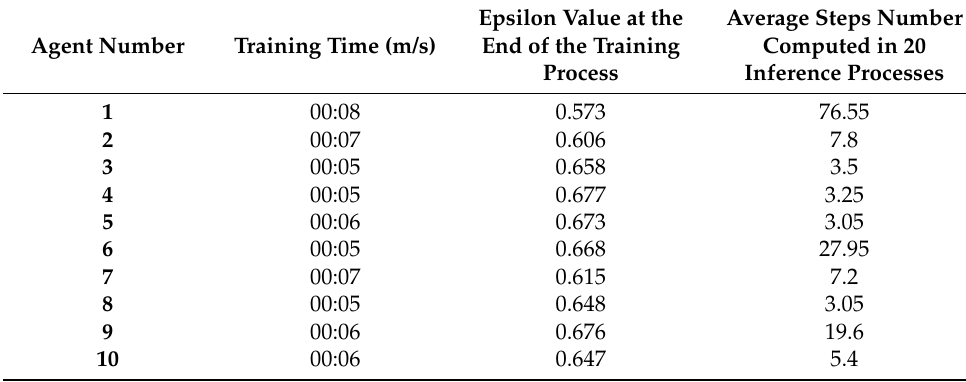
Table 12. Details of the training approach when the ϵ decrease was equal to 0.000005. Agent